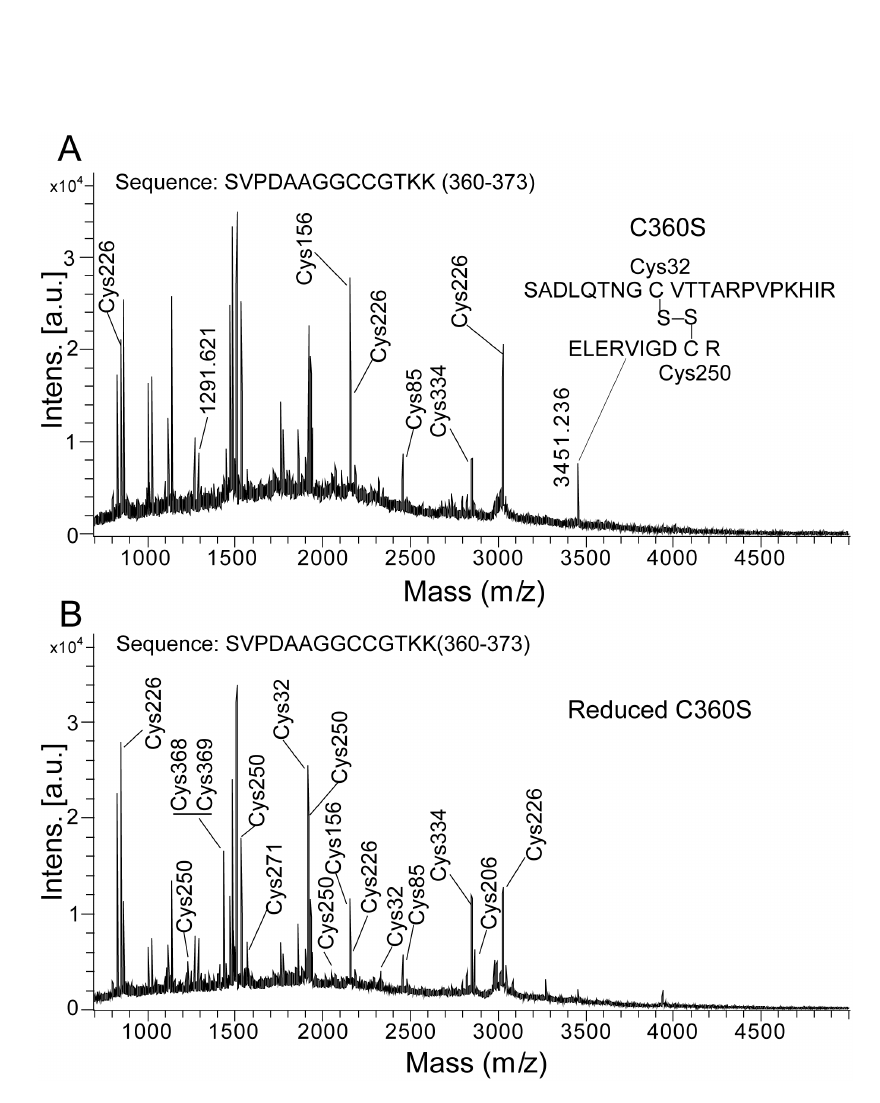
Figure 2. MALDI-TOF-MS spectra of the tryptic digests of C360S (A) and its reduced form (B). doi:10.1371/journal.pone.0110924.g002 PLOS ONE |